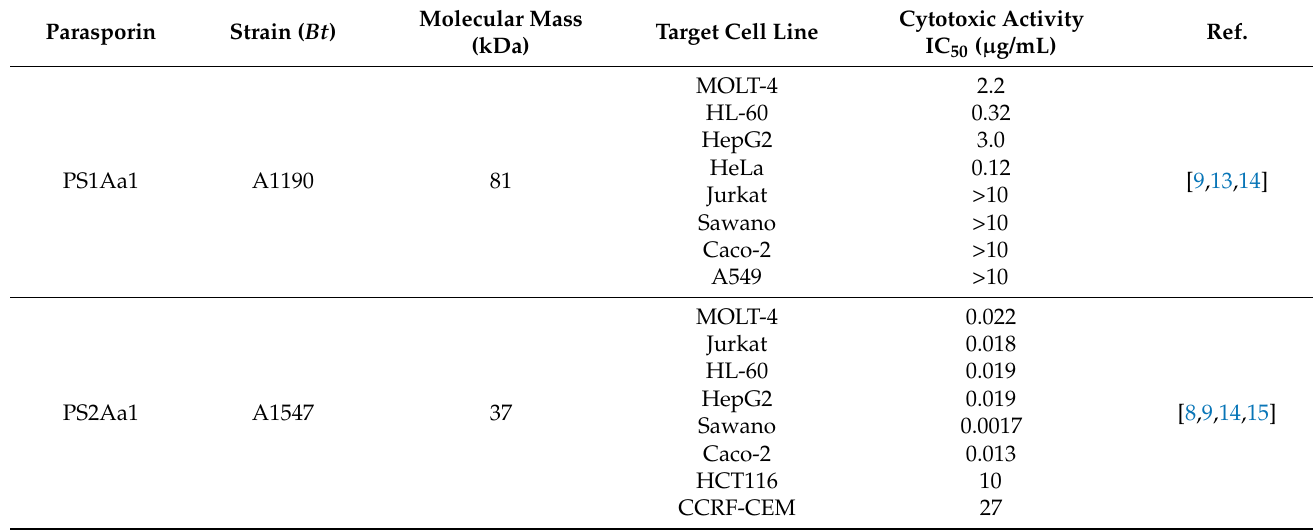
Table 1. Parasporin families, family-containing strains, molecular weights, target cells, cytotoxic activity, and references. Parasporin Strain ( Bt